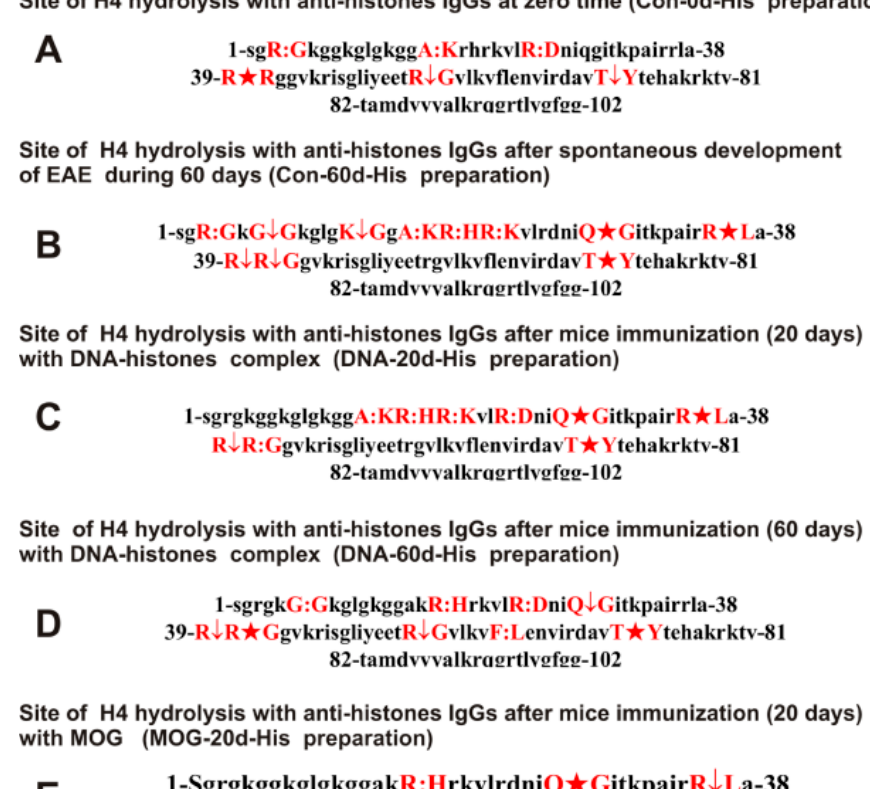
Figure 6. Sites of H4 hydrolysis by IgGs against histones corresponding to different IgG preparations. Major sites of H4 cleavage are shown by stars ( ★ ), moderate ones by arrows ( ↓ ), and minor sites of the cleavages by colons (:) ( A – E ).